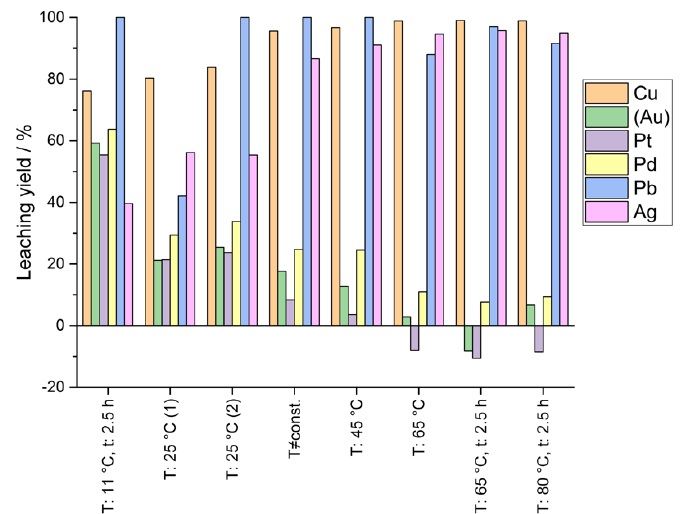
Figure 5. Leaching yields of several elements at different leaching temperatures (calculation based on analysis of leaching residue via aqua regia digestion); solid conc.: 50 g/0.1 L; t: 5 h.